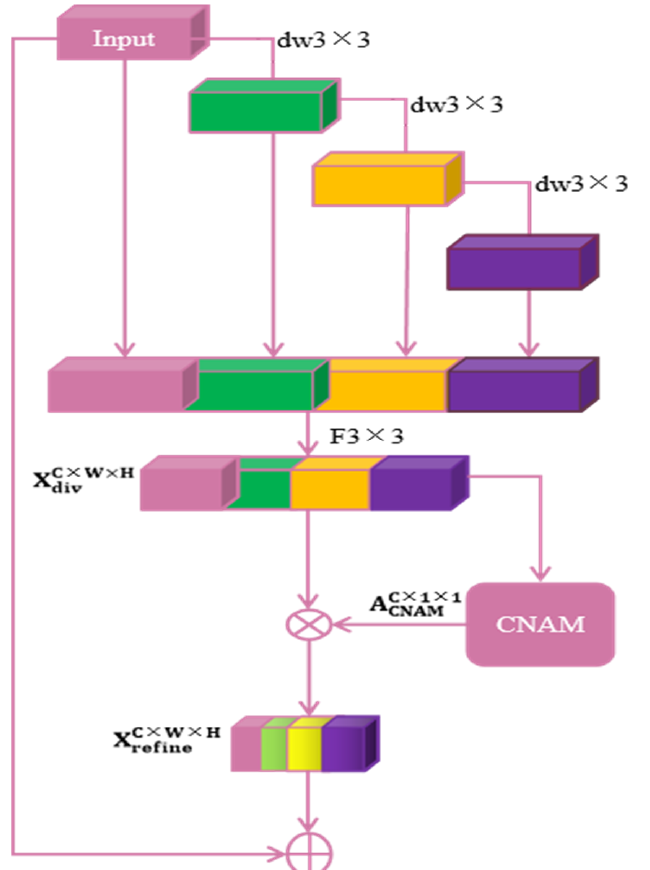
Figure 2. Structure of the OSA module.